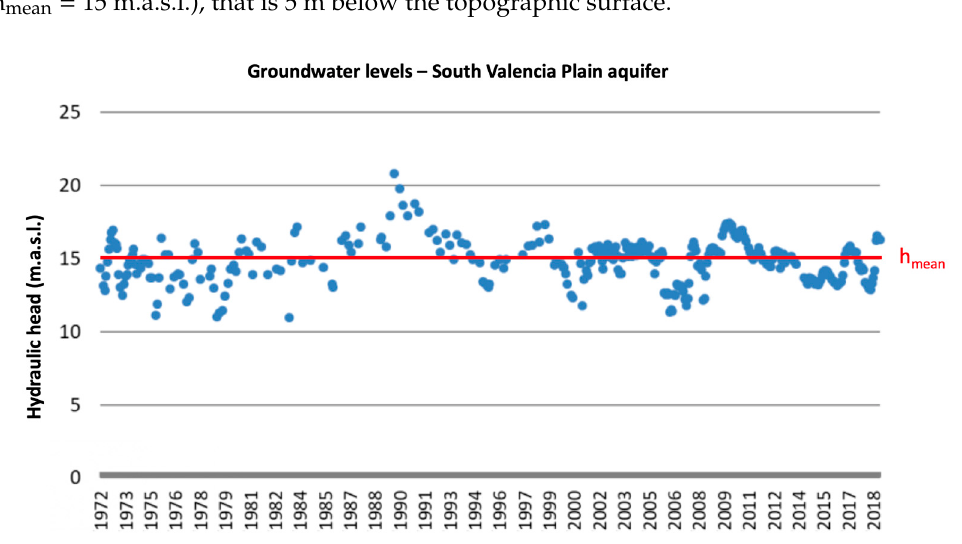
Figure 2. Evolution of piezometric levels (1972–2018) at the sample location.